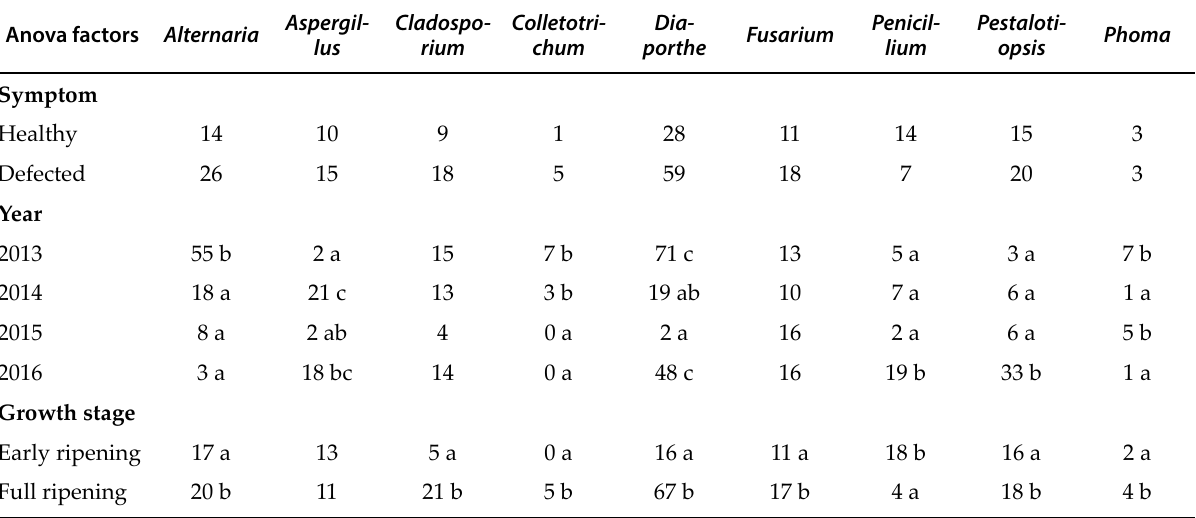
Table 4. Mean incidence of the nine most isolated fungal genera in healthy and defected hazelnuts, sampled at early and full ripening in the 4 year period of 2013 to 2016 in Caucasus region. Symptoms, year and nut maturity stage were consid- ered as factors in